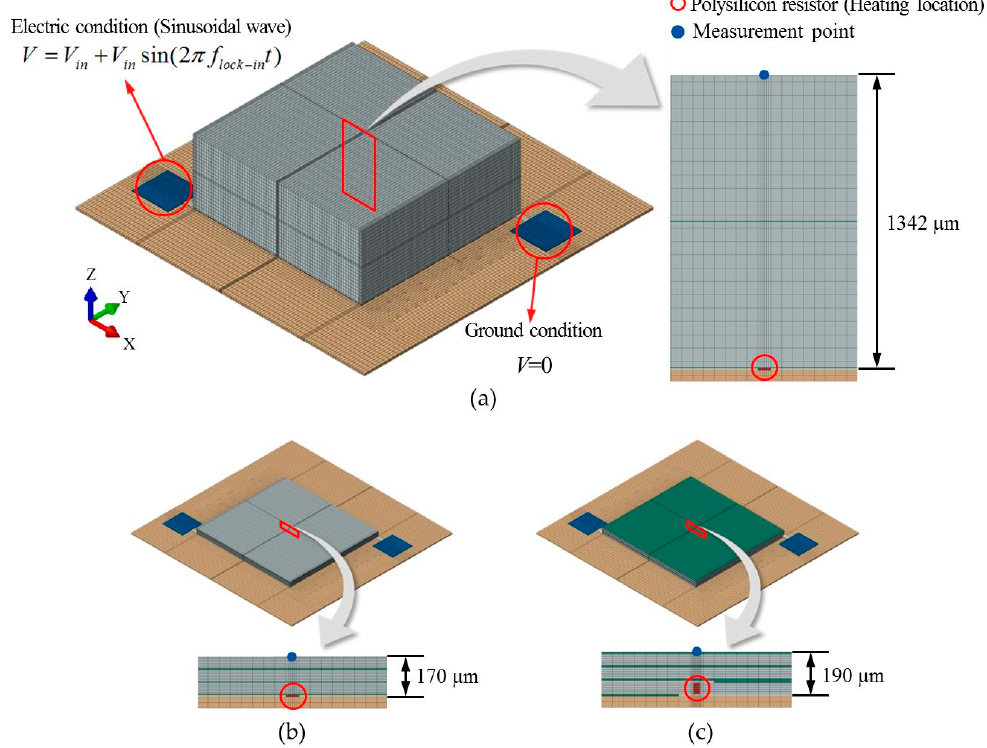
Figure 5. 3D FE models used in FE simulation: ( a ) two-layered SSHSC; ( b ) three-layered SSHSC; ( c ) 3D TSV integrated package purposed model.